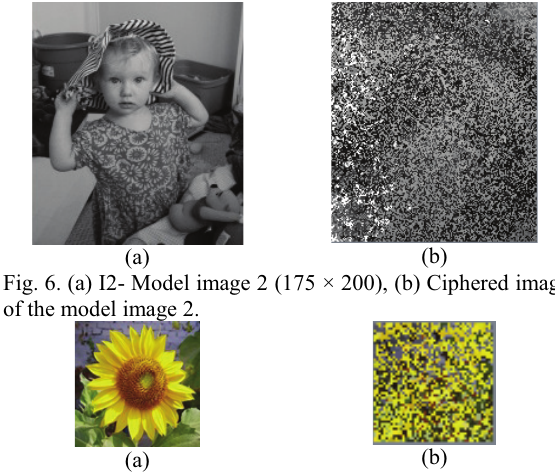
(a) (b) Fig. 7. (a) I3- Model image 3 (50 × 50), (b) Ciphered image of the model image 3.